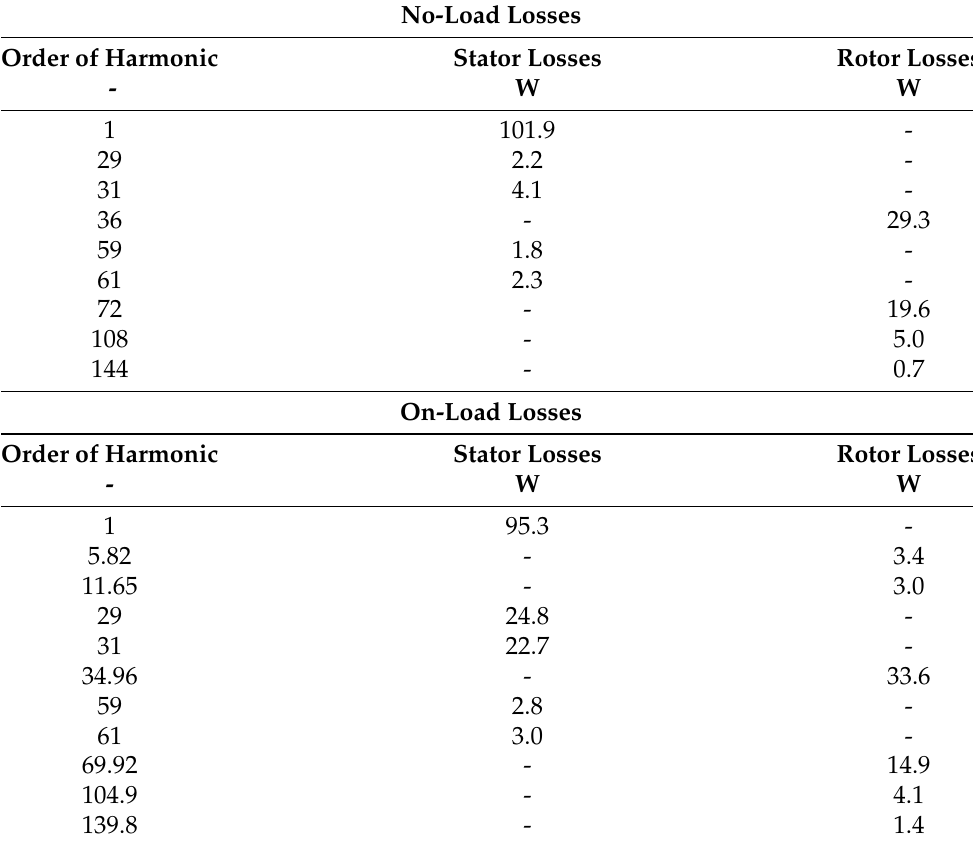
Table 4. Harmonic iron